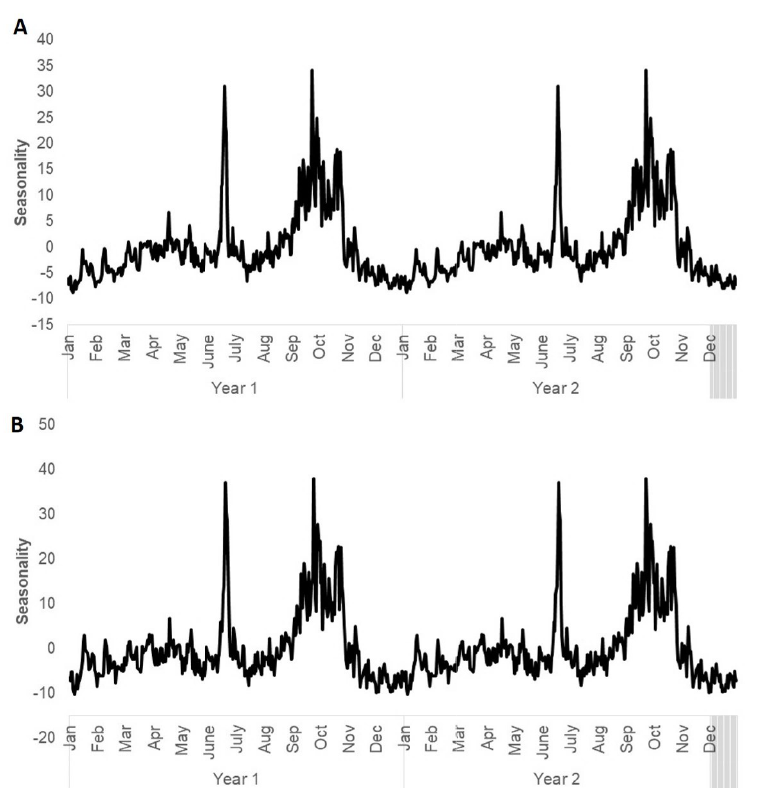
Figure 4. The seasonality of ( A ) PM 2.5 and ( B ) PM 10 . The first two years are shown for easier visualization.